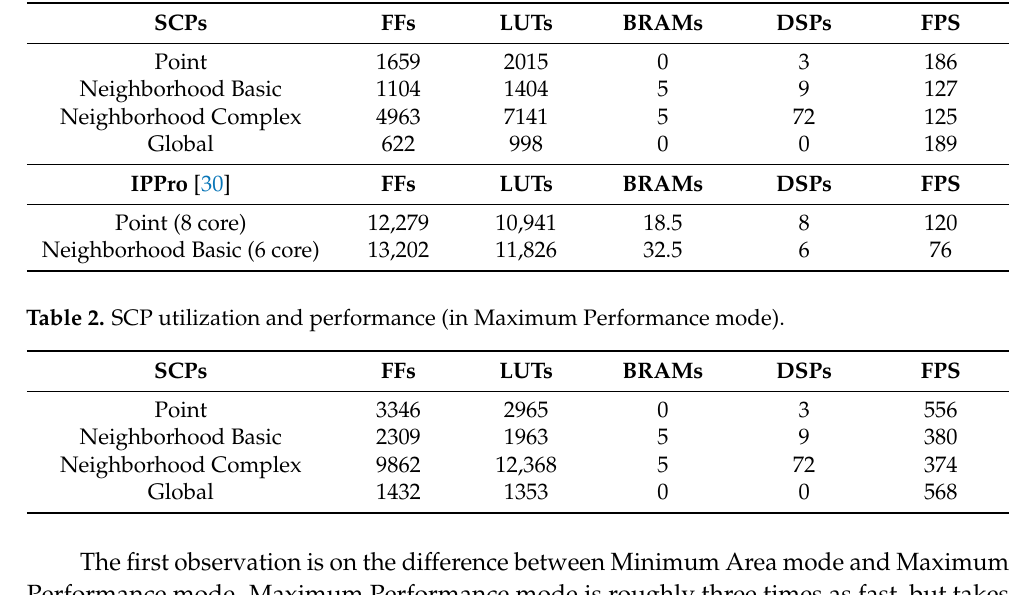
Table 1. Comparison between SCP (in Minimum Area mode) and IPPRO in utilization and performance.